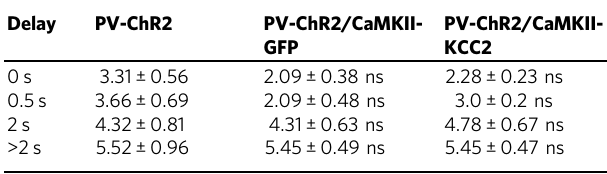
Table 1 Mean duration of baseline ictal discharges in experiments with different delays in different experimental